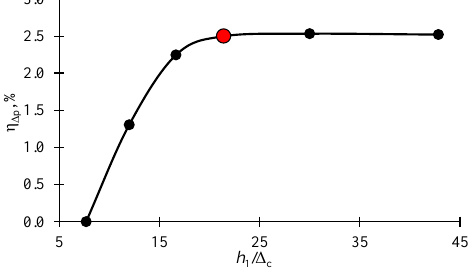
Figure 2. Mesh independence test.